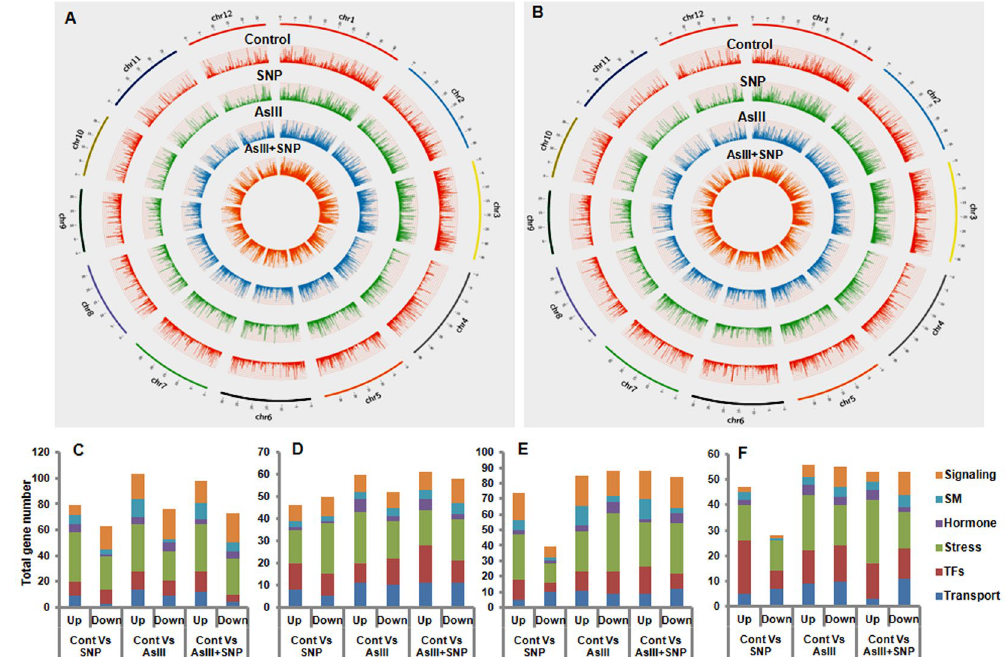
Figure 4. Expressions patterns of globally expressed genes at different chromosomes were analyzed by using expression (FPKM) value on 4 th ( A ) and 12 th day ( B ), respectively. Total gene number of signaling, hormone, stress, TFs, transporter and secondary metabolism (SM) related genes ( C ) on 11, ( D ) on 12 chromosomes at 4 th day and ( E , F ) on 11 and 12 chromosomes respectively at 12 th day. Results showed enrichment (relative expression) of stress related genes on 11 and 12 chromosomes in the AsIII + SNP treatment among analyzed gene